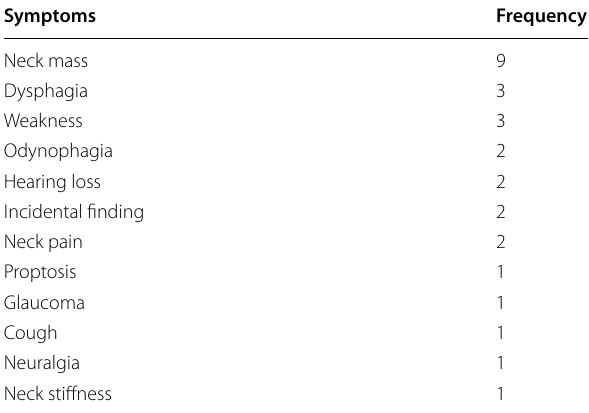
Table 1 Prevalence of presenting symptoms in the